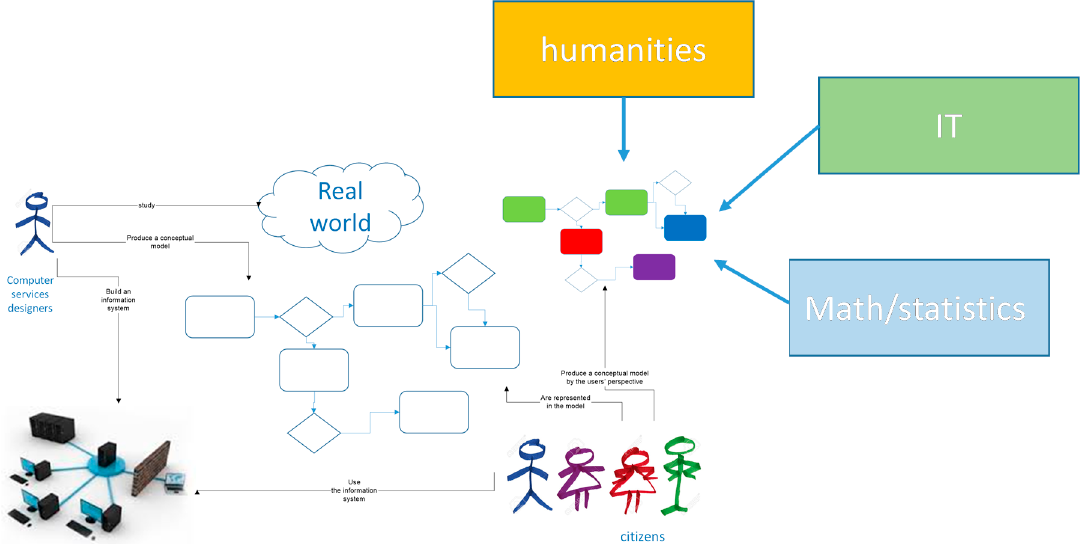
Figure 5. Interdisciplinary content delivery.